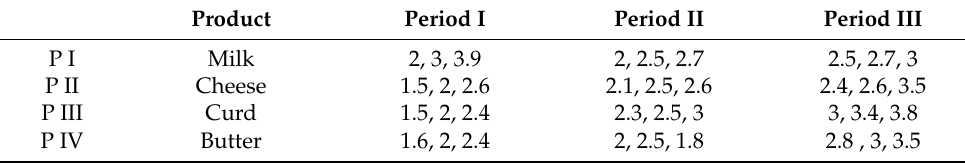
Table A3. Holding cost at